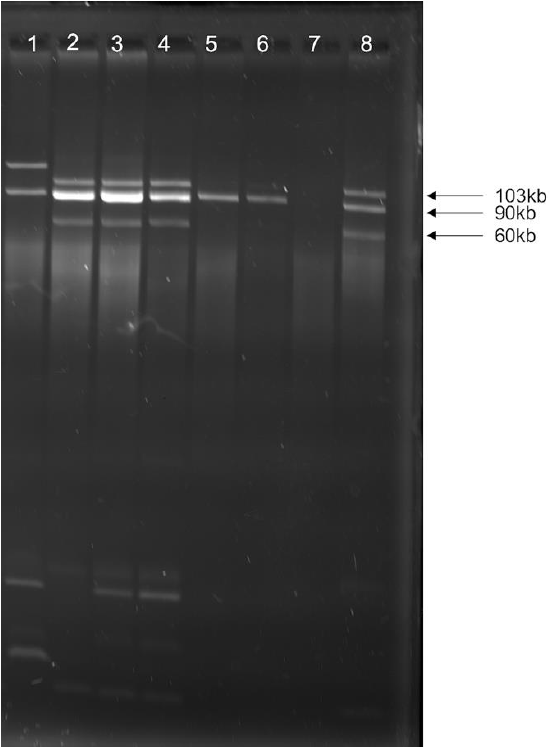
Figure 7. Plasmid profiles of donor, recipient, and transconjugant strains. ( 1 ) Donor IA-EC-0018; ( 2–4 ) transconjugant χ7122 (pIA-EC-0018-2); ( 5–6 ) trans-conjugant χ6092 (pIA-EC-0018-2); ( 7 ) recipient χ6092; ( 8 ) recipient χ7122.